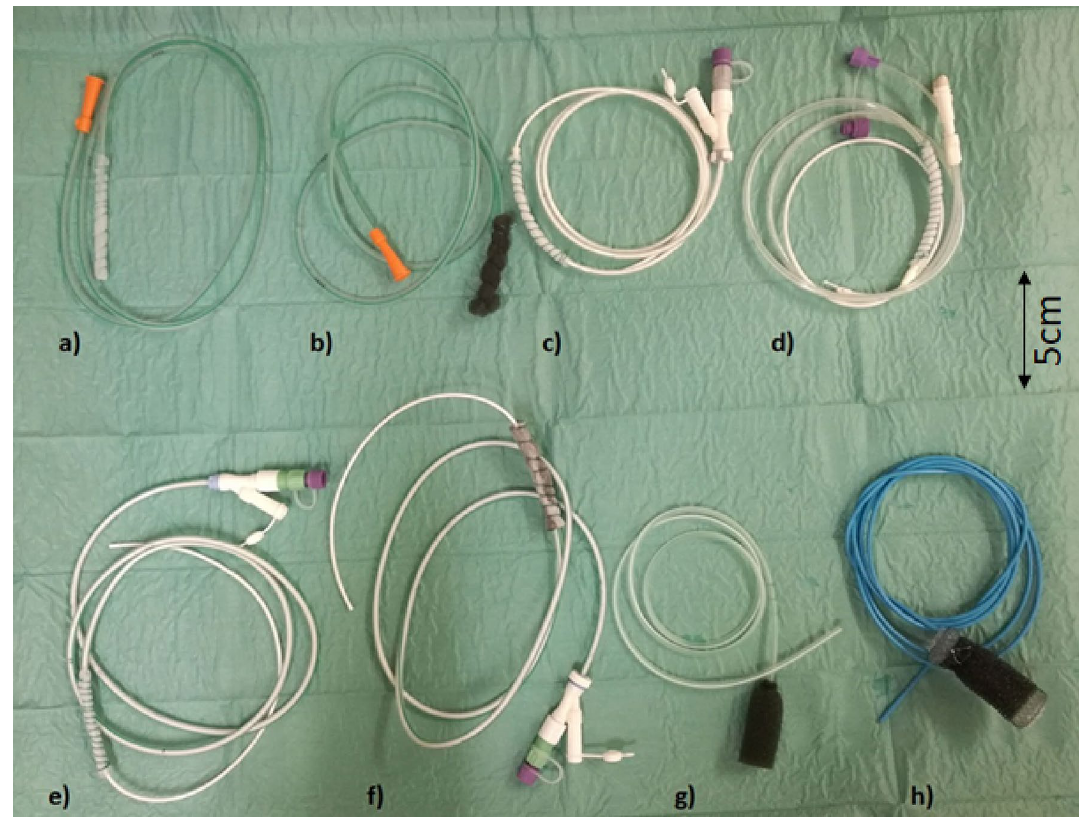
Figure 2. Tested open-pore suction devices for ENPT of the UGIT. ( a ) Self-made gastric tube with CNP-film wrapped around the distal perforations. ( b ) Self-made PU sponge drainage on a 16Ch nasogastric tube. ( c ) Enteral feeding tube with two lumen and wrapped CNP-film around the gastric tube. ( d ) Enteral feeding tube with three lumen and wrapped CNP-film around the gastric tube. ( e ) Self-made feeding tube, using a 16Ch nasojejunal tube (length 125 cm) with an introduced 9Ch intestinal tube and CNP-film around the gastric tube. ( f ) Self-made combination of two OPSD. The distal end of a nasogastric tube (16Ch) is wrapped with a PU sponge. Over the sponge the CNP-film is single-layered placed. ( g ) The commercially available Eso-Sponge system a PU sponge with a fixed 9Ch drainage tube. ( h ) The new commercially available combination product VAC-Stent with integrated 9Ch drainage tube. ENPT: endoscopic negative pressure therapy; OPSD: open-pore suction device; PU: polyurethane; UGIT: upper gastrointestinal tract.